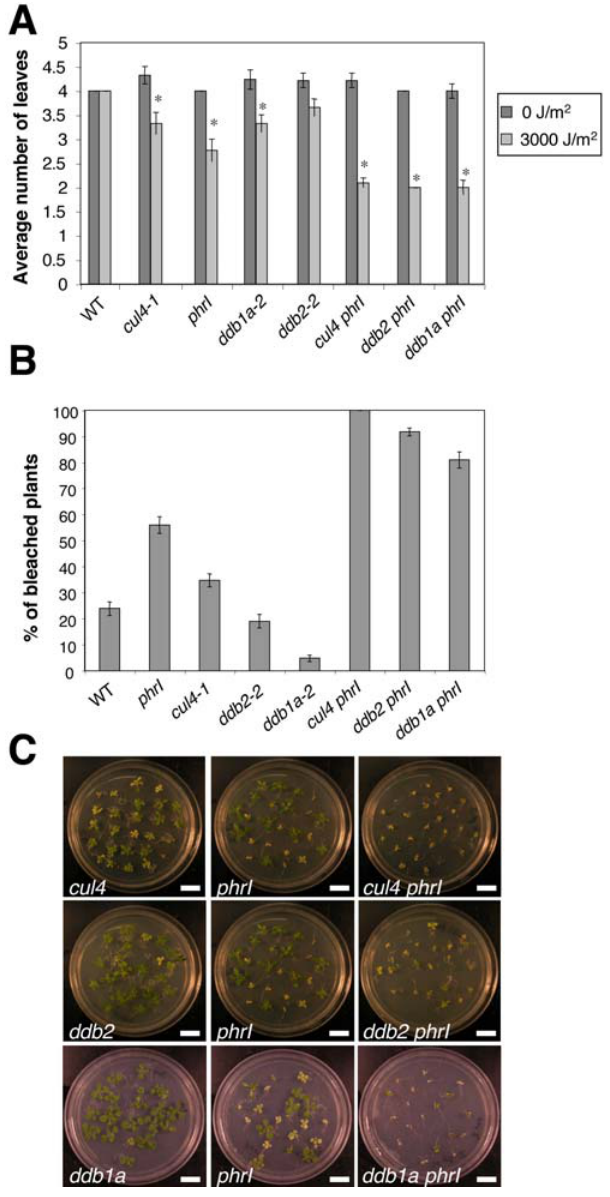
Figure 4. Genetic interactions between CUL4, DDB1A, DDB2 and UVR2. Ten-day-old single ( cul4-1 , ddb1a-2 , ddb2-2 , phrI ) and double mutant plants ( cul4-1 phrI , ddb1a-2 phrI , ddb2-2 phrI ) were irradiated with UV-C (3000 J/m 2 ) 3 times in row every 2 days. (A) Graph representing the average number of leaves. Counting was one week after the last UV-C exposure. At least 20 plants were used per replicate and this experiment was duplicated. T-test *p , 0.05, compared to WT plants. (B) Graph representing the percentage of bleached plants. Counting was 2 weeks after the last UV-Cexposure.Atleast 20plants wereused per replicateand this experiment was duplicated. (C) Pictures showing the phenotype of plants 14 days after the last UV-C exposure (Bar=1 cm).